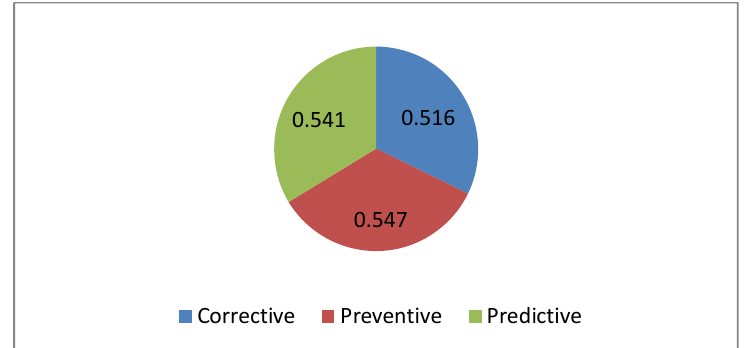
Fig. 3. The relative importance of different maintenance strategies